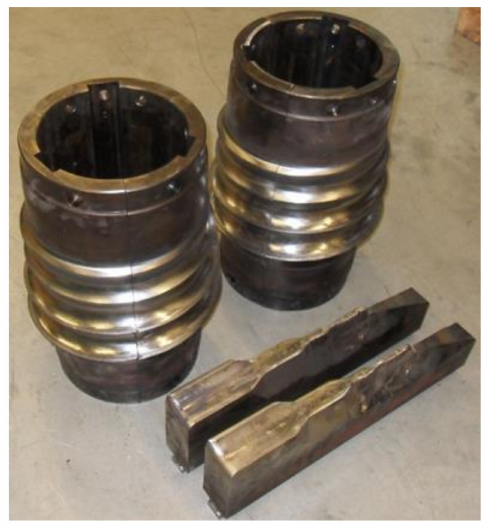
Figure 16. Laboratory skew rolling mill—the real machine.